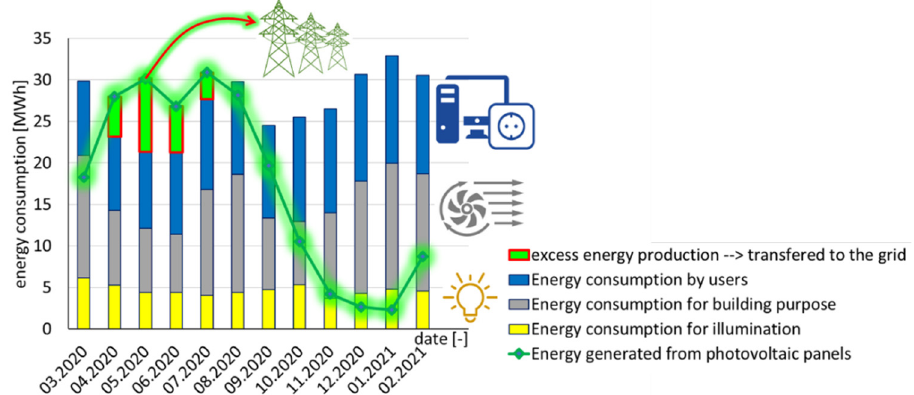
Figure 13. Distribution of the energy consumption by the building.